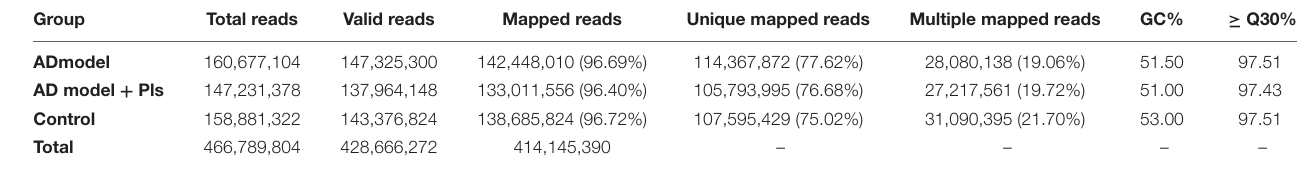
TABLE 1 | Summary of the transcriptome sequencing